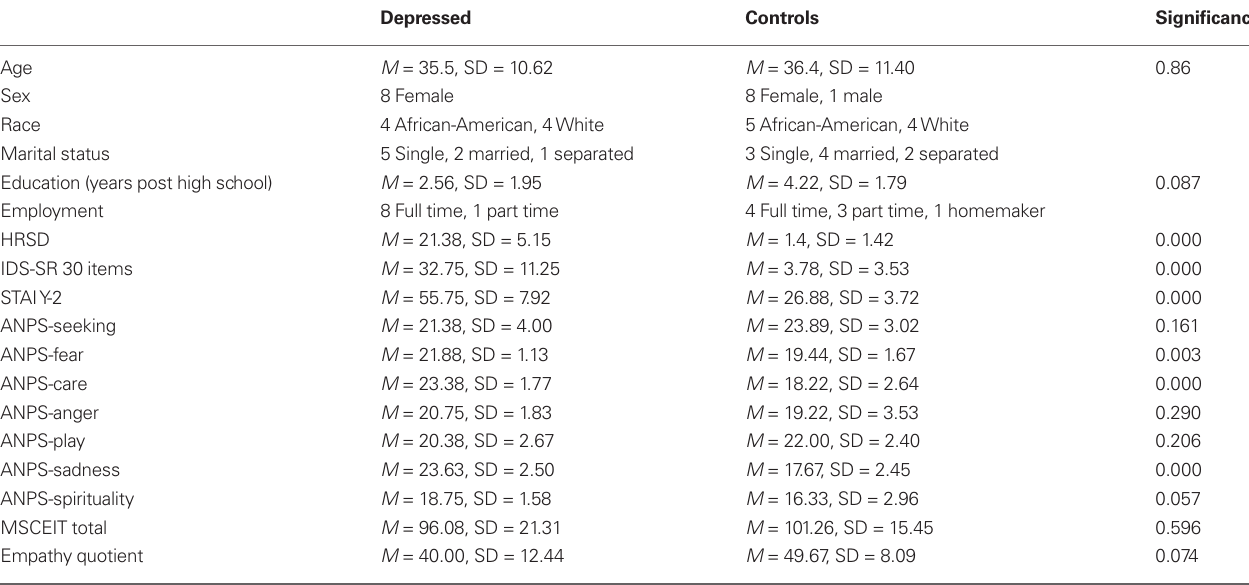
Table 1 | Demographics and clinical characteristics of unmedicated depressed subjects and their matched healthy controls. Significant differences were found in depressive symptoms (HDRS, IDS-SR, ANPS-Sadness), anxiety symptoms (STAY-I and ANPS-Fear), and capacity to care (ANPS-Care). Note that a trend for differences on Empathy Quotient and ANPS-Spirituality.